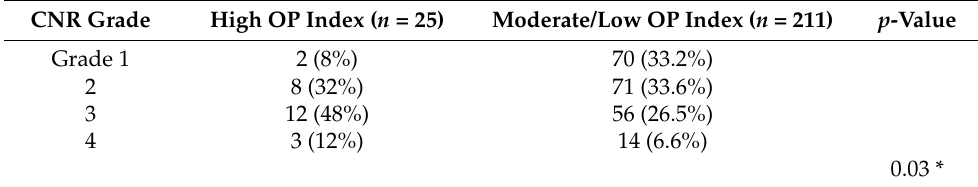
Figure 2. Radiologic findings, including OPLL ( A ), OALL ( B ), OLF ( C ), SSL or nuchal ligament ( D ), and DISH ( E ) in the high OP-index group and moderate/low OP-index group. DISH, diffuse idiopathic skeletal hyperostosis; OALL, ossification of the anterior longitudinal ligament; OLF, ossification of the ligamentum flavum; OPLL, ossification of the posterior longitudinal ligament; SSL, supra- and interspinous ligaments * p < 0 .05, ** p < 0 .01, *** p < 0 .001. Table 3. CNR grade according to high or moderate/low OP index